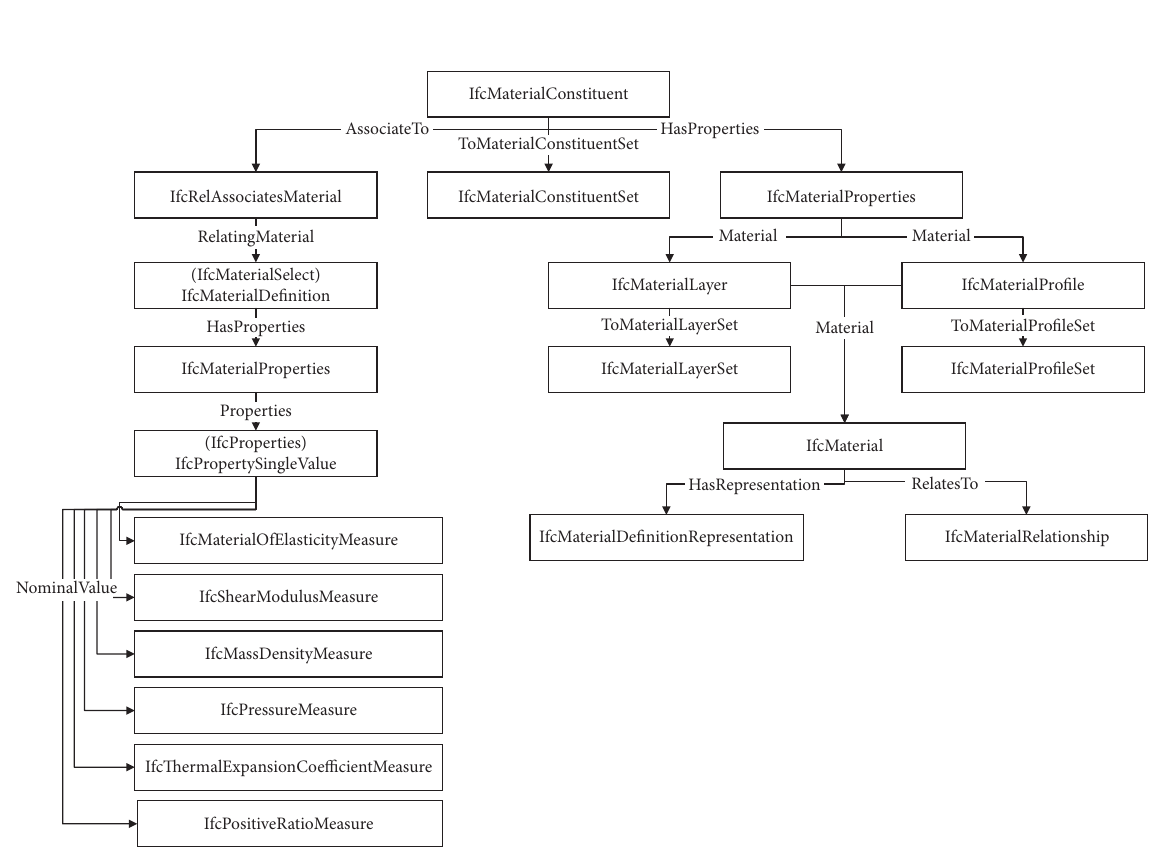
Figure 8: Structure of the IFC4 version of